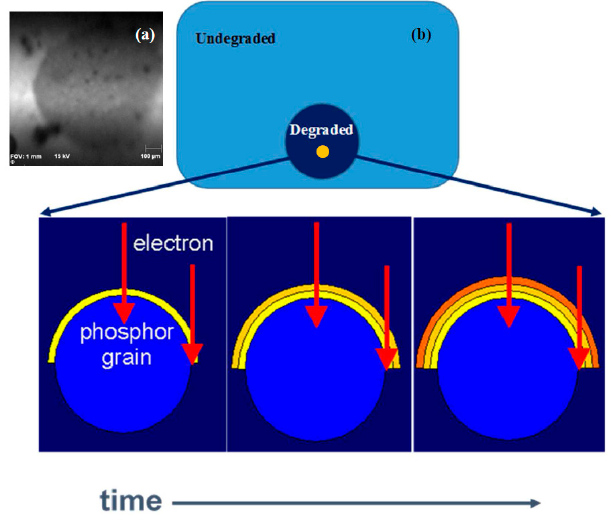
Figure 4. ( a ) A schematic of the degraded spot with an enlargement of one of the particles showing the growth of the degraded thin film with prolonged electron bombardment time; and ( b ) secondary X-ray Imaging (SXI) of a 24 H degraded spot of Y 2 SiO 5 :Ce.